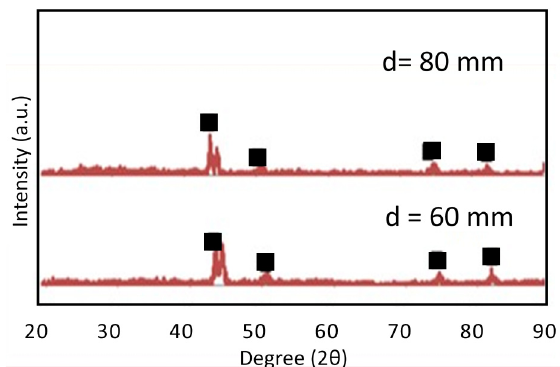
Figure 7. XRD patterns of SPS films before heat treatment. ( d = deposition distance, ■ : Fe (substrate)).